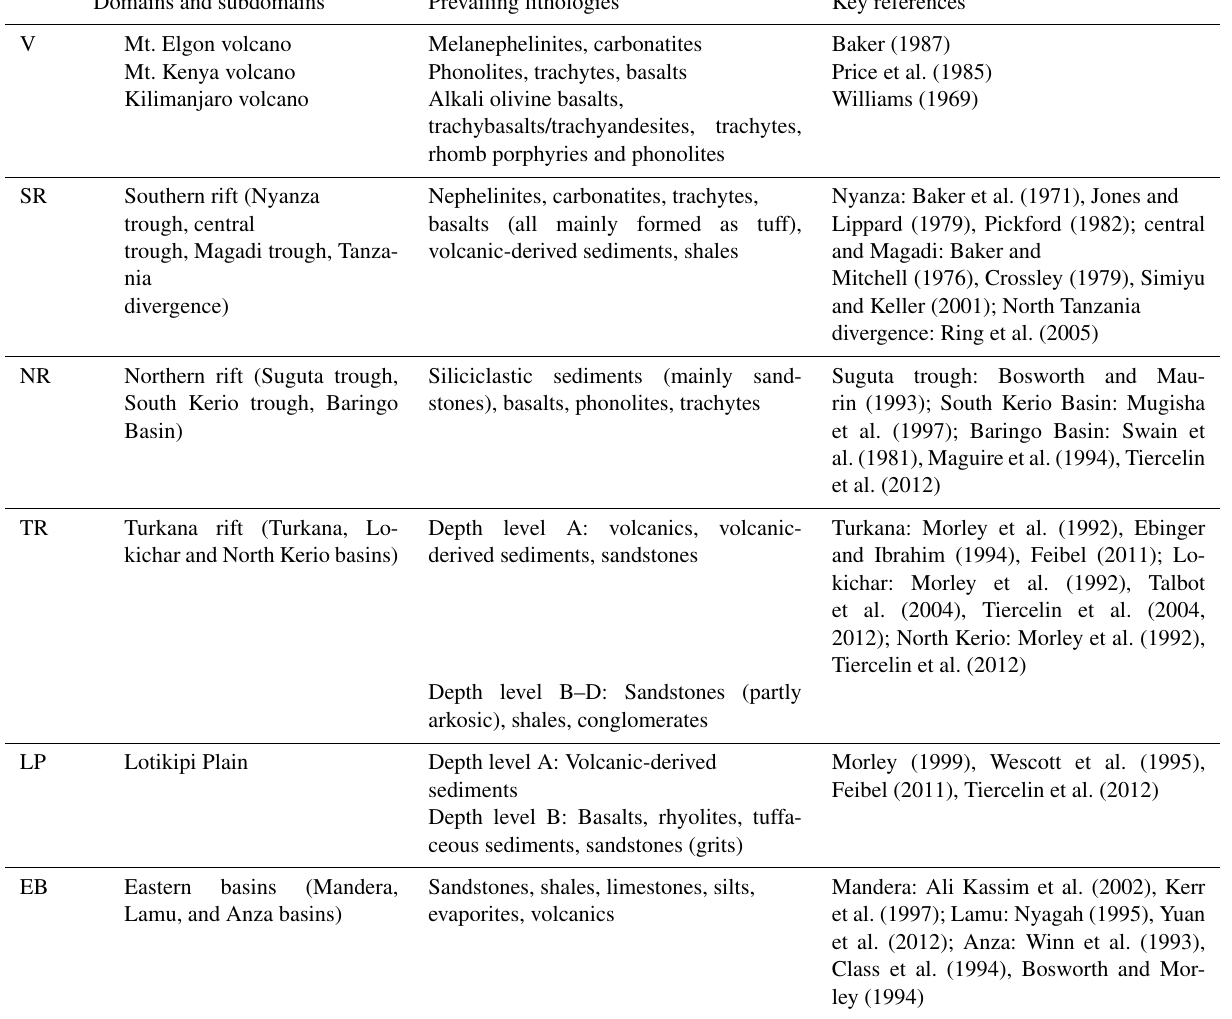
Table 1. Devised lithological domains for modelling the sedimentary and volcanic infill of the basins. Domains and